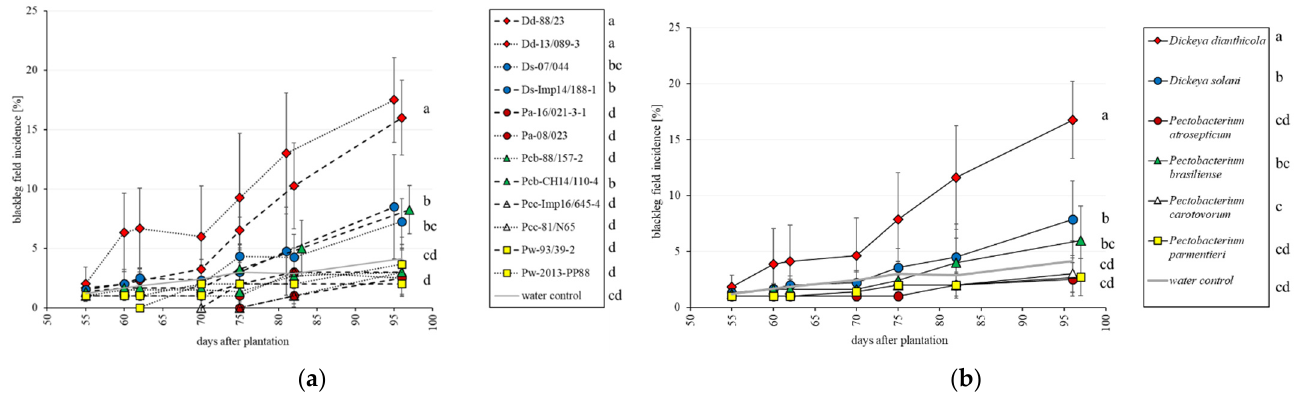
Figure 1. Timelines of the observed blackleg field incidence for the different 12 strains ( a ) and the different 6 species ( b ), average of two strains of similar color, in the field assay for 2018. Each single value of the timeline is the mean of four repetitions of 100 observed plants, with standard deviation bars. Different letters indicate statistical differences according to pairwise multiple comparison (ANOVA based) of the mean incidence value between the strains at the last observation. In the chart, letters are grouped together. Details statistical differences between strains or species are given right to the legends. Negative control with water is given in gray. The assay was repeated in 2020.